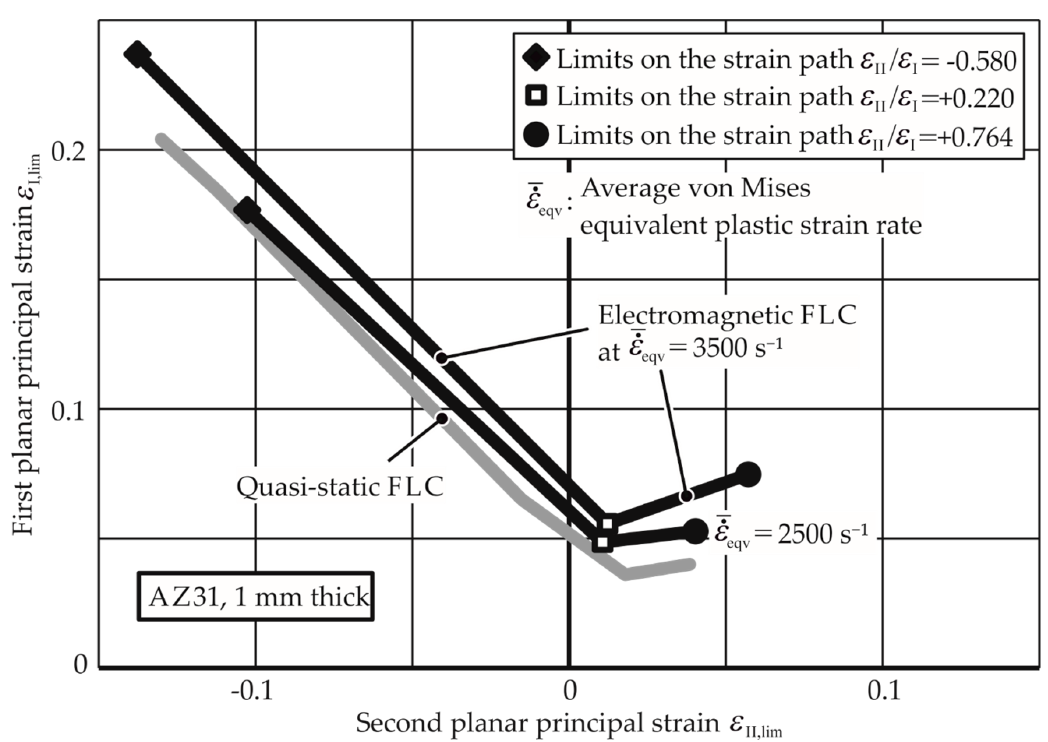
Figure 18. Electromagnetic forming limit curves (FLC) of Mg AZ31-O at different strain rates. The quasi-static FLC is given for comparison.